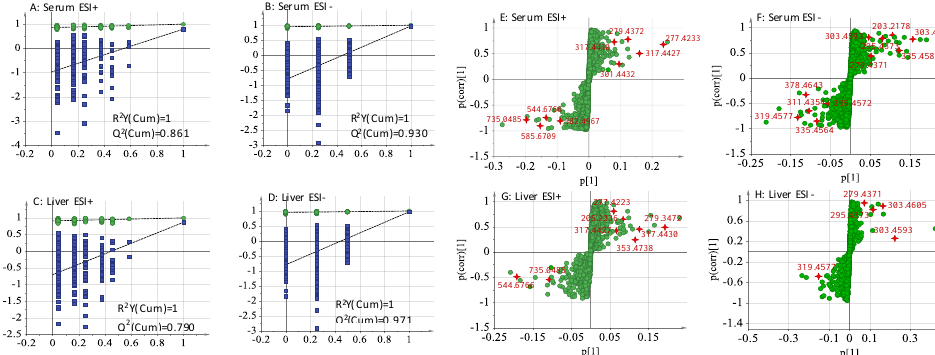
Figure 6. Principal component analysis (PCA) ( A – D ) and OPLS-DA ( E – H ) score plots of serum and liver metabolic profiling. Aiming at obtaining the maximum separation between the model group and com- pound 2e group, orthogonal projections to latent structures discriminant analysis (OPLS- DA), a supervised method of pattern recognition, was then established in both ESI+ and ESI– modes (Figure 6E–H). In the OPLS-DA score plots, each spot also represented a serum Permutation test was then performed to validate the prediction ability and the relia- bility of OPLS-DA. Figure 7A–D showed the test results. All Q 2 -values (blue spots) to the left were lower than the original points to the right, indicating that the OPLS-DA dis- played good prediction ability and reliability.